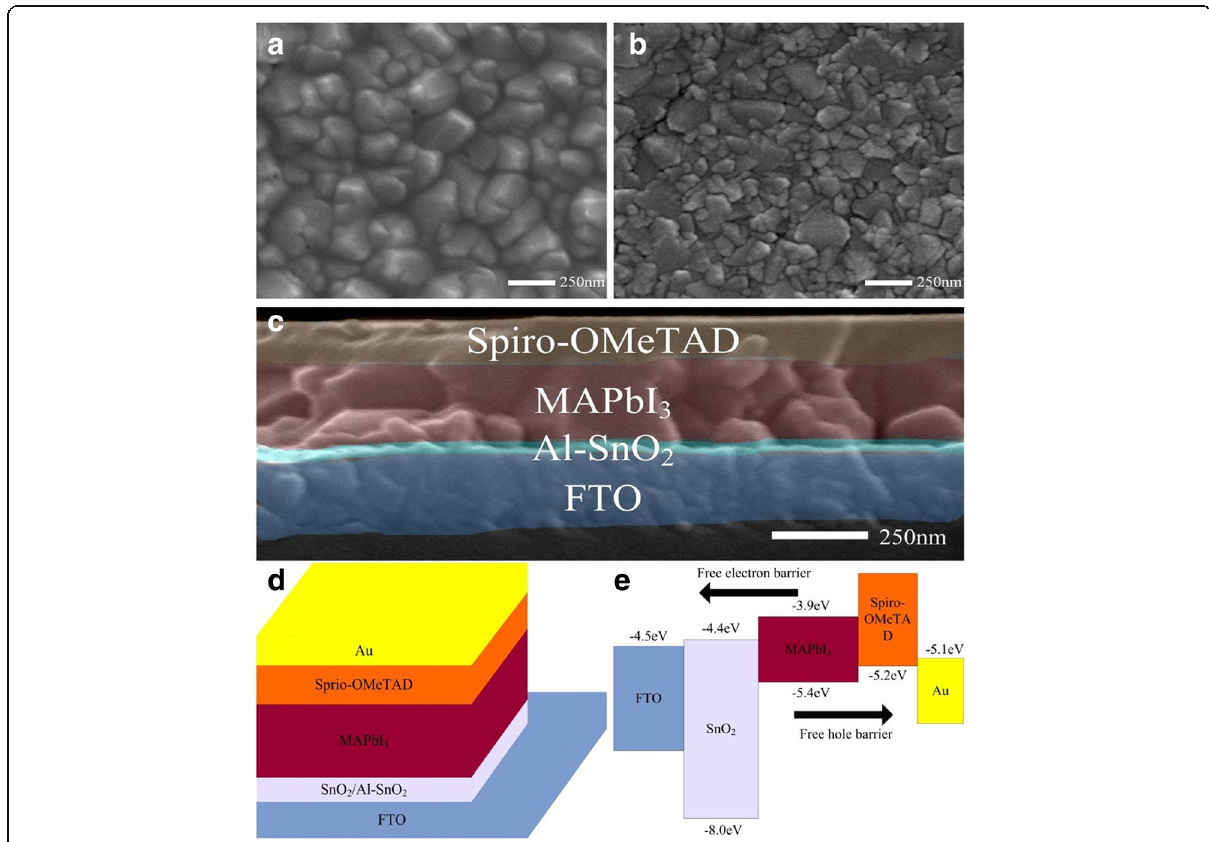
Fig. 1 a Top view SEM images of low-temperature solution-processed SnO 2 on FTO and b bare FTO. c Cross-sectional SEM image of the planar perovskite solar cell based on Al-SnO 2 , d schematic of the PSCs grown on Al-SnO 2 , and e energy band diagram of the